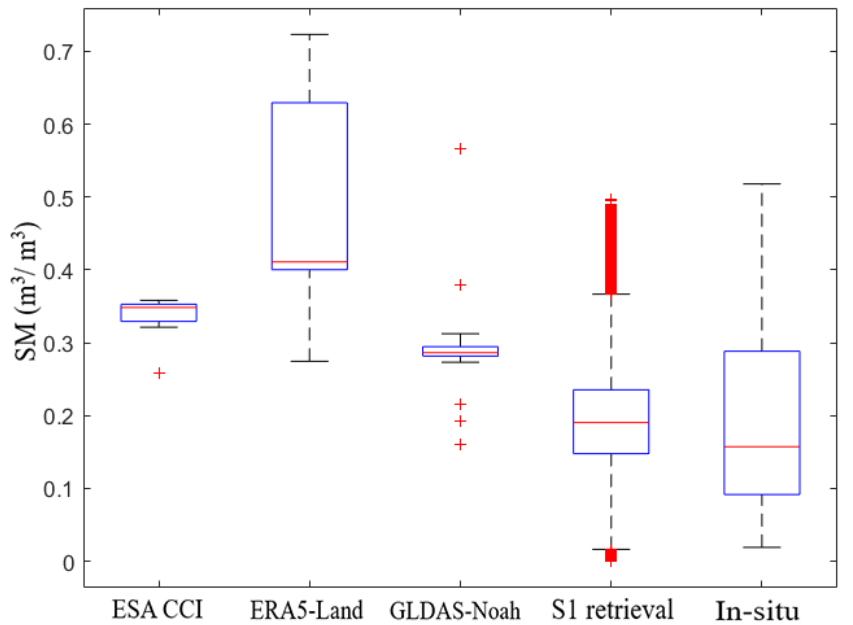
Figure 13. The box plot of SM for the three SM products and S1 retrieval results for the Tuotuo river basins on 2 July 2018. The box line diagram has six parts: lower edge, lower quartile, median, upper quartile, upper edge, and outliers beyond the upper and lower edges.